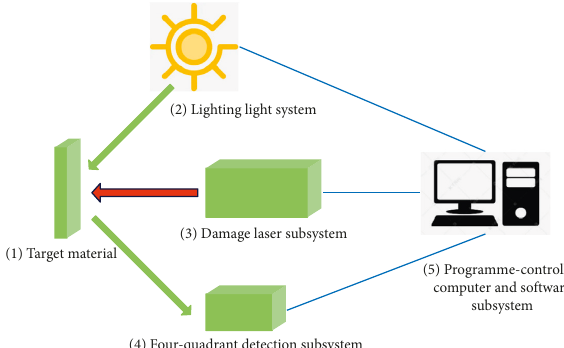
Figure 1: Schematic diagram of the overall